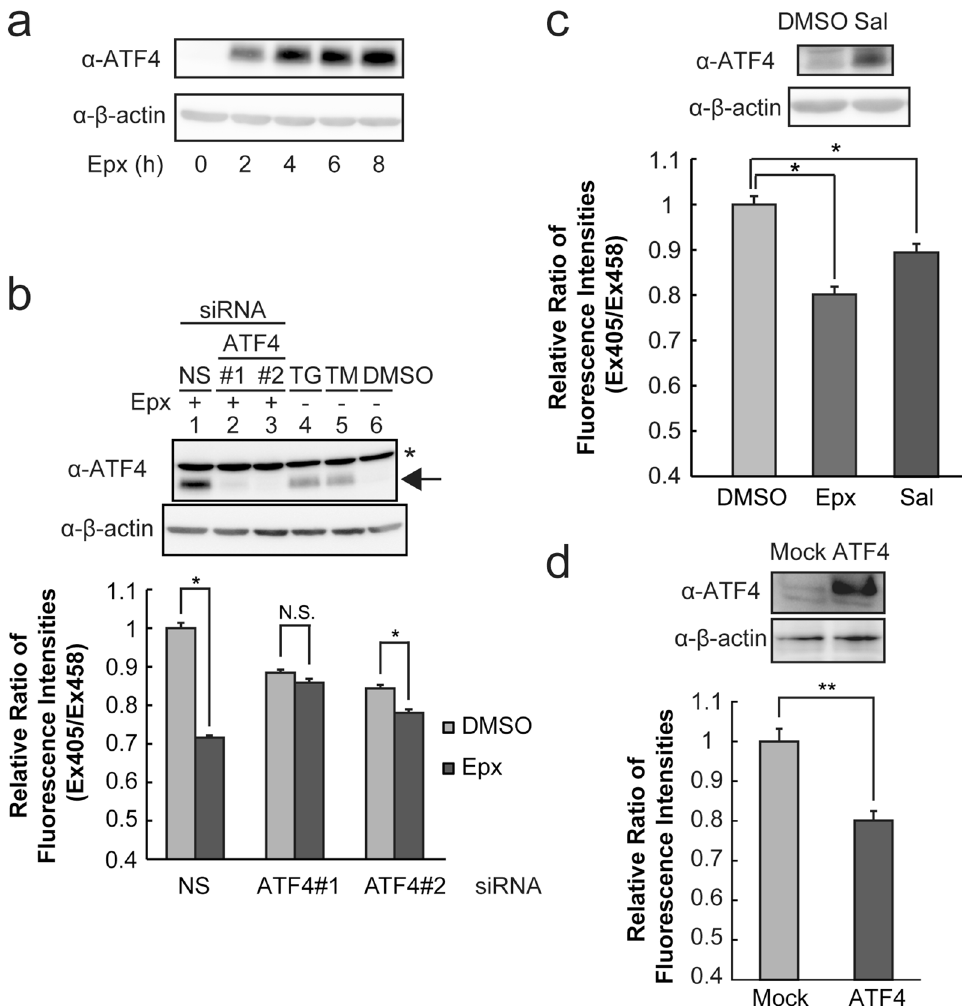
Figure 3. ATF4 was responsible for reduction of the ER redox state after proteasome inhibition. ( a ) Induction of ATF4 proteins after proteasome inhibition was detected at indicated times after Epx treatment. ( b ) Effect of ATF4-knockdown on ER redox state. Western blotting of ATF4 (upper panel) was performed. Thapsigargin (TG) and tunicamycin (TM) were used as positive controls. The relative ratio of fluorescence intensities of ERroGFP S4 (lower panel) was determined. Cells after 48 h of siRNA transfection and 8 h of Epx treatment were lysed or used to determine the fluorescence intensities. ( c ) Effect of ATF4-induction by salubrinal treatment on ER redox state. Salubrinal, an eIF2α dephosphorylation inhibitor (10 μM), was treated for 12 h, which increased ATF4 level (upper panel). After the treatment, the relative ratio of fluorescence intensities was determined (lower panel). ( d ) Effect of overexpression of ATF4 on ER redox state. Expression plasmid containing ATF4 gene was transfected in HeLa cells stably expressing ERroGFP S4. The relative ratio of fluorescence intensities from ERroGFP S4 was determined at 24 h after transfection. The relative ratio was normalized as described in Supplementary Fig. 7. Quantified values are shown as the means ± S.E. of three independent experiments. * P < 0.05 and ** P < 0.01 versus control in each